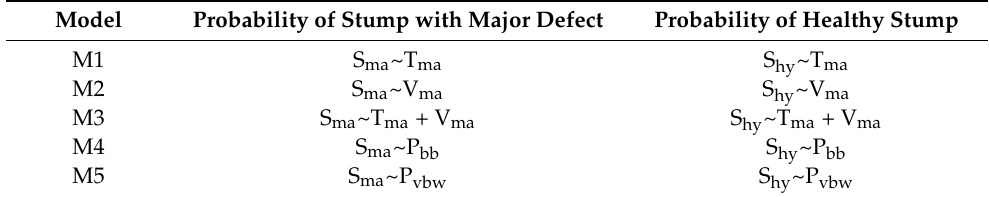
Table 2. The generalized linear models (1–5) based on two different binary variables (stump with ma- jor defect and healthy stump). Acronym explanations are given in the materials and methods chapter.